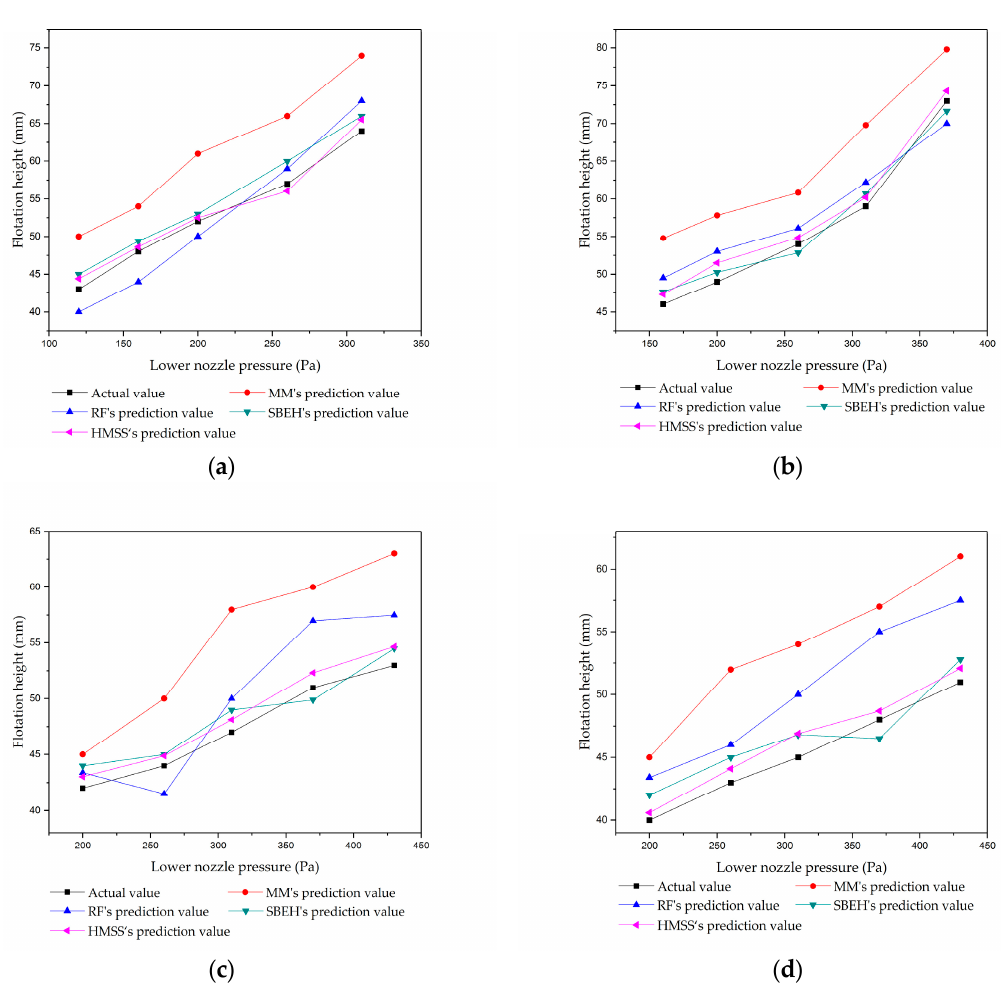
Figure 9. The prediction and actual floating height in the stable state: ( a ) thickness = 1.5 mm, upper pressure = 40 Pa; ( b ) thickness = 1.5 mm, upper pressure = 90 Pa; ( c ) thickness = 2 mm, upper pressure = 40 Pa; and ( d ) thickness = 2 mm, upper pressure = 90 Pa. RF: Random forest, HMSS: Hybrid model for stable state, MM: mechanistic model, SBEH: Hybrid selective bagging ensemble model.